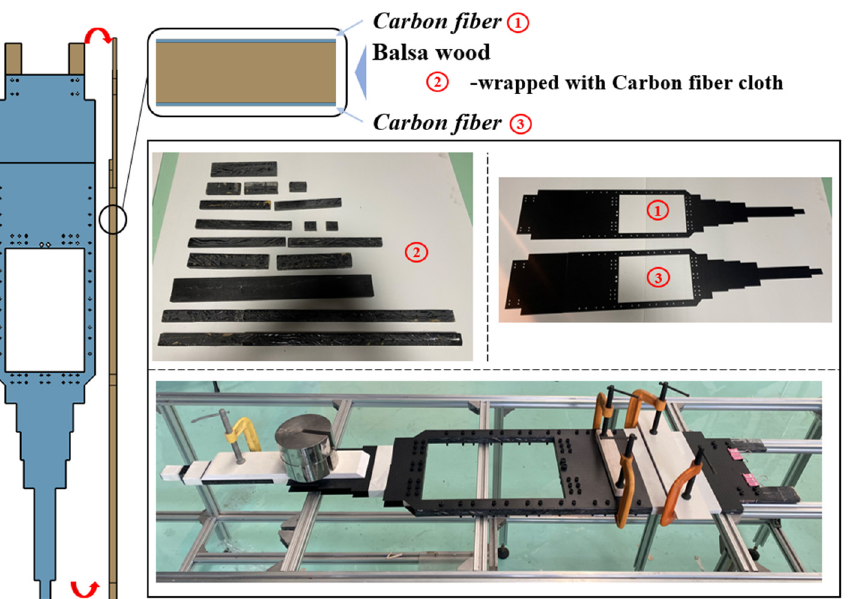
Figure 11. Structure design and assembly of the fuselage core board. The materials of the core board: ① carbon fiber; ② balsa wood; and ③ carbon fiber.